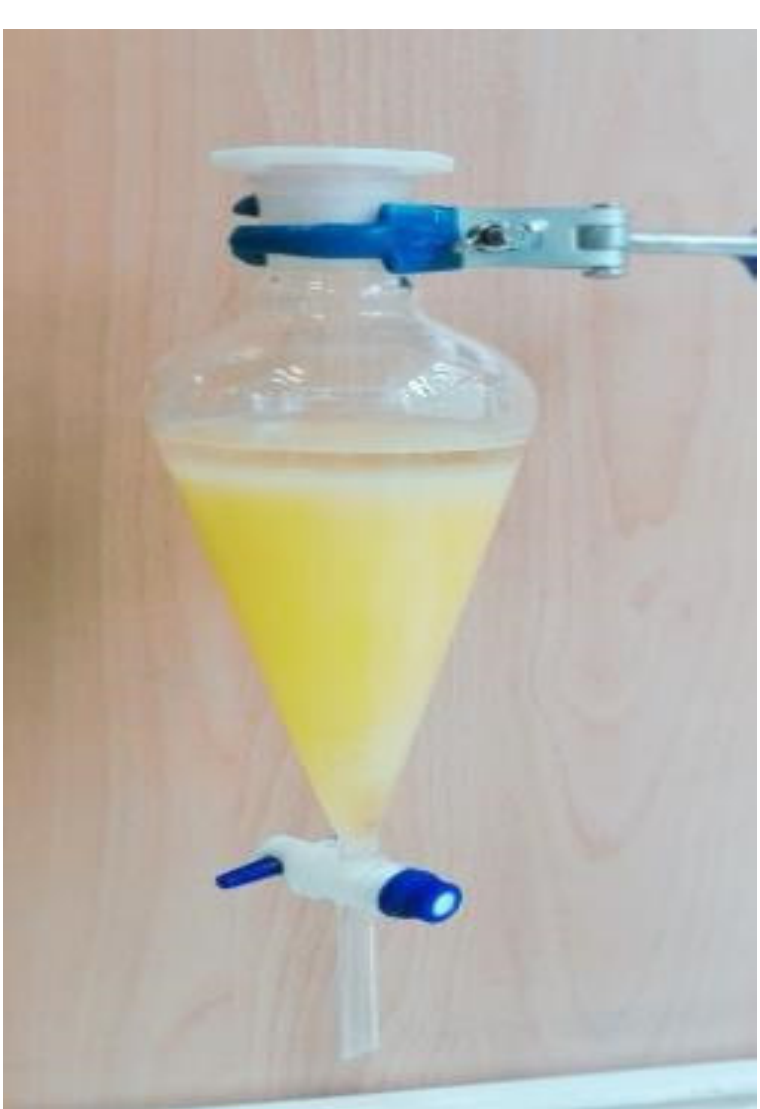
Figure 2. A prepared sample placed in separating funnel after the esterification process.